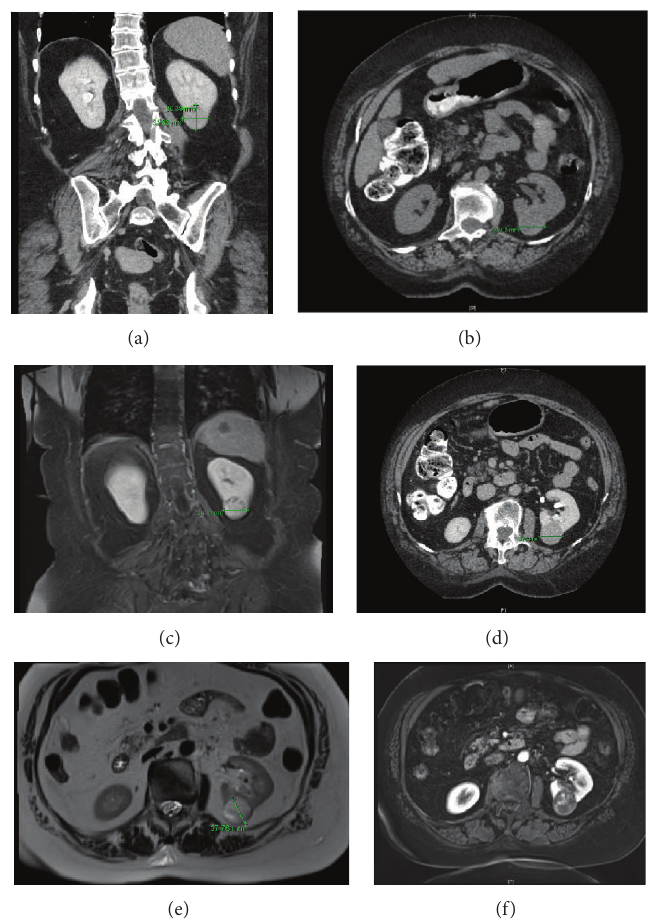
Figure 1: (a)–(c) CT revealed a solid tumor arising from the posterior cortex of the kidney near the inferior pole. The tumor measured 3.5 cm in greatest diameter. (d)–(f) MRI revealed an exophytic mass arising from the posterior cortex of the kidney near the inferior pole. The mass demonstrated pouch and its internal enhancement, heterogeneous high T2 signal, and restricted